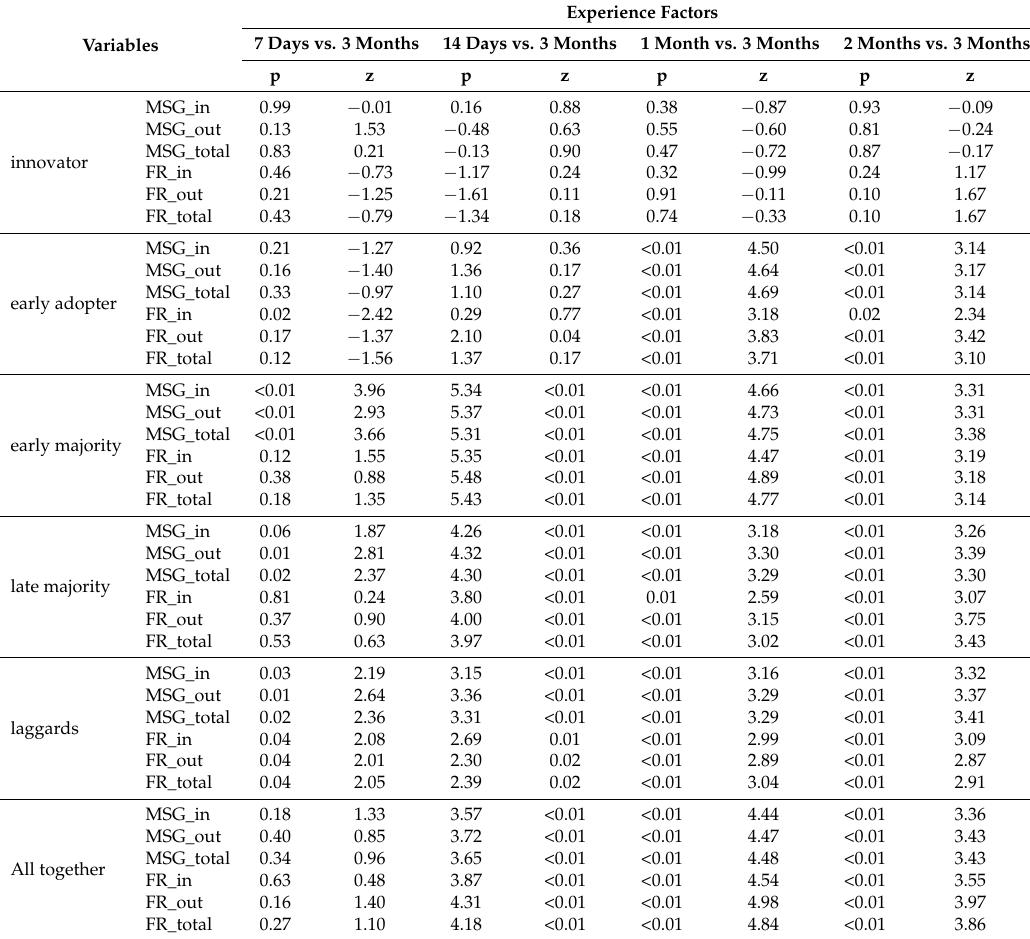
Table A3. Intergroup comparisons using the life-length of a product as a dependent variable and as non-variable